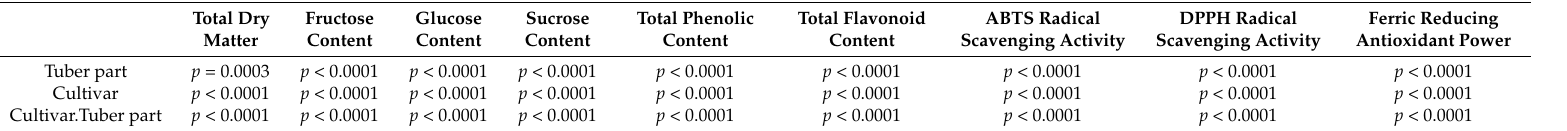
Table 1. ANOVA results of total dry matter, fructose, glucose and sucrose content, total phenolic content, total flavonoid content, 2,20-azino-bis(3-ethylbenzothiazoline-